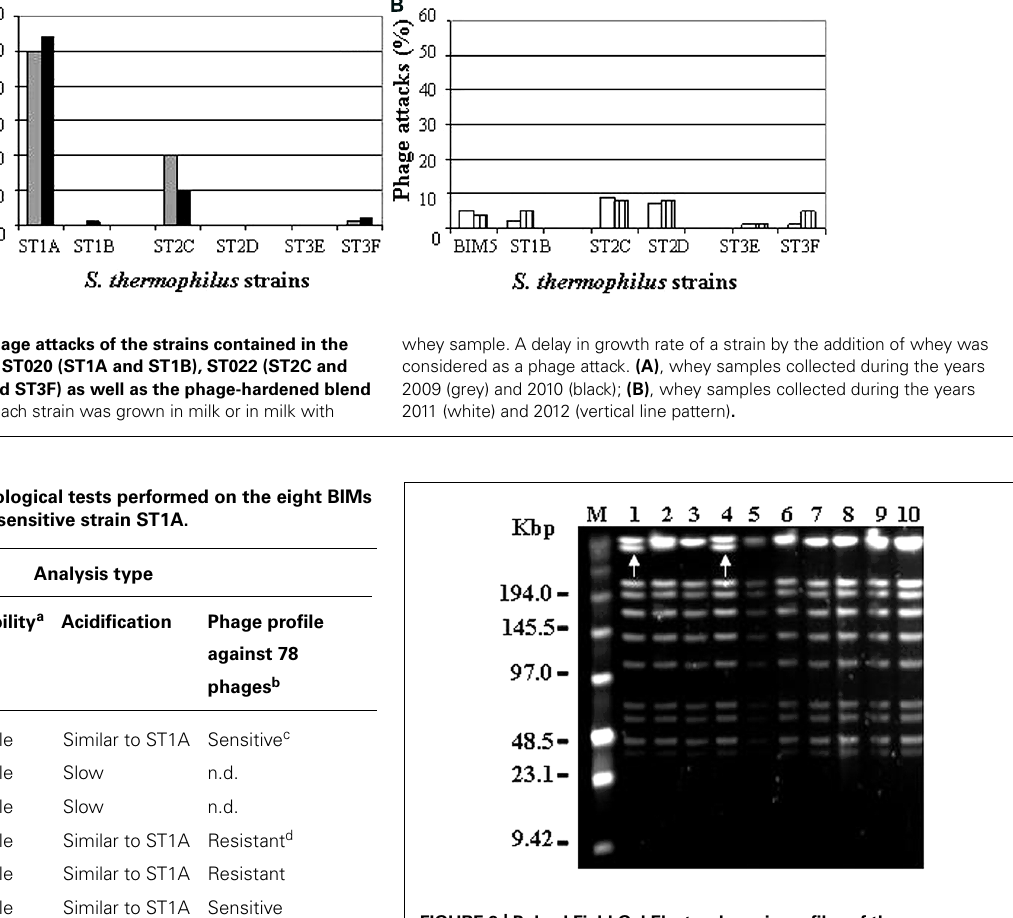
FIGURE 3 | Pulsed Field Gel Electrophoresis profiles of the phage-sensitive strain ST1A and its generated BIMs. The enzyme used for digestion is SmaI. ST1A, lane 1 and 4; BIM1, lane 2; BIM2, lane 3; BIM3, lane 5; BIM4, lane 6; BIM5, lane 7; BIM6, lane 8; BIM7, lane 9; BIM8, lane 10.The white arrow indicates the band that is missing in the BIMs